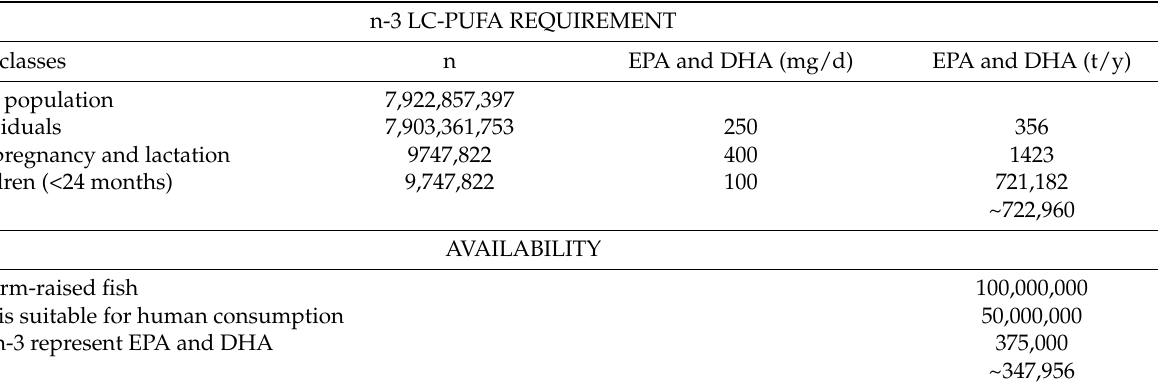
Table 1. Estimated global requirements of n-3 LC-PUFA and their availability from fish. n-3 LC-PUFA